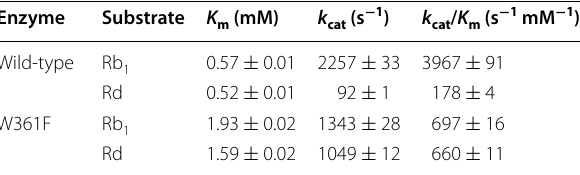
Table 2 Kinetic parameters of the wild-type and W361F variant enzymes for ginsenosides Rb